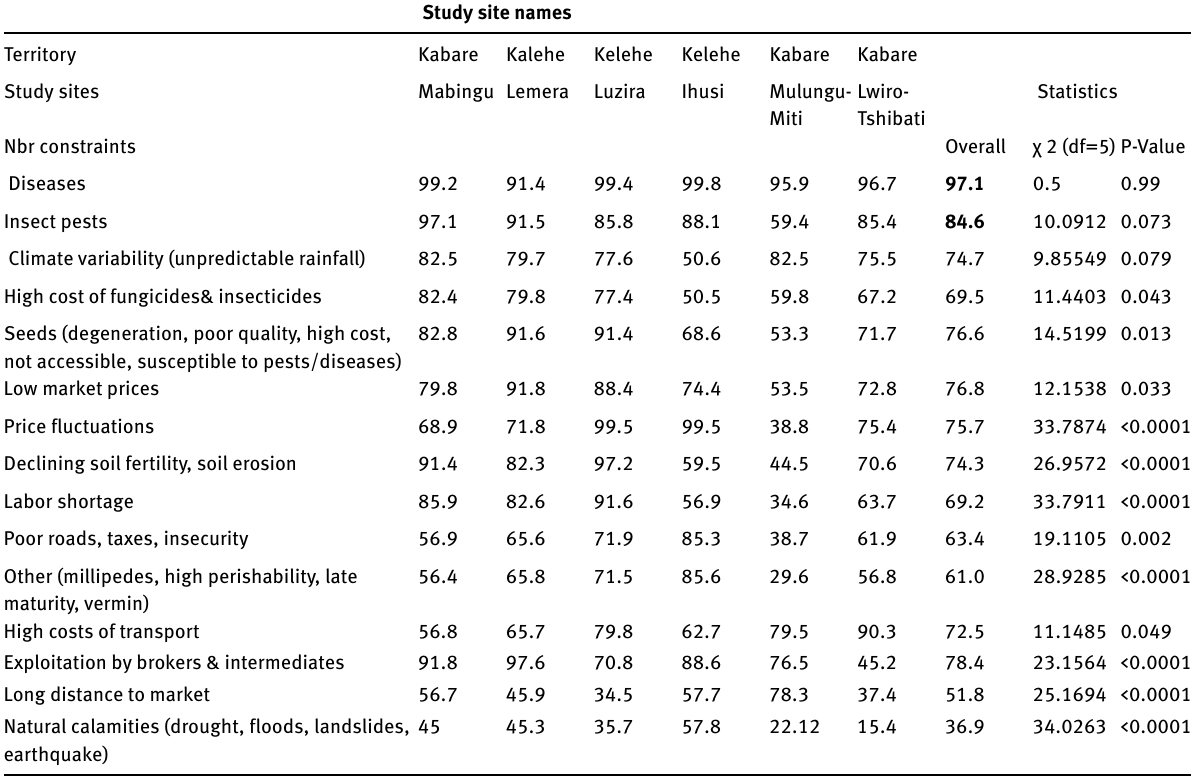
Table 4: Percentage (%) of potato farmers reporting each constraint in the six study sites of Kalehe and Kabare Territories, South-Kivu Pro- vince, eastern DRCongo (2016 survey; n = 300 respondents)